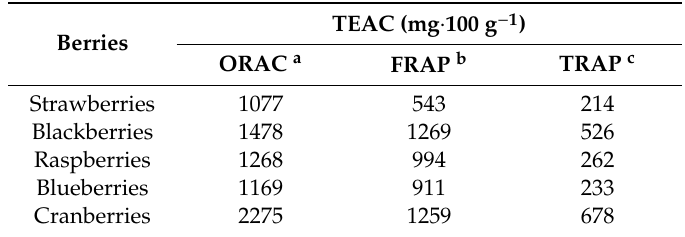
Table 2. Survey of TEAC values in pulp of berries determined by other assays.